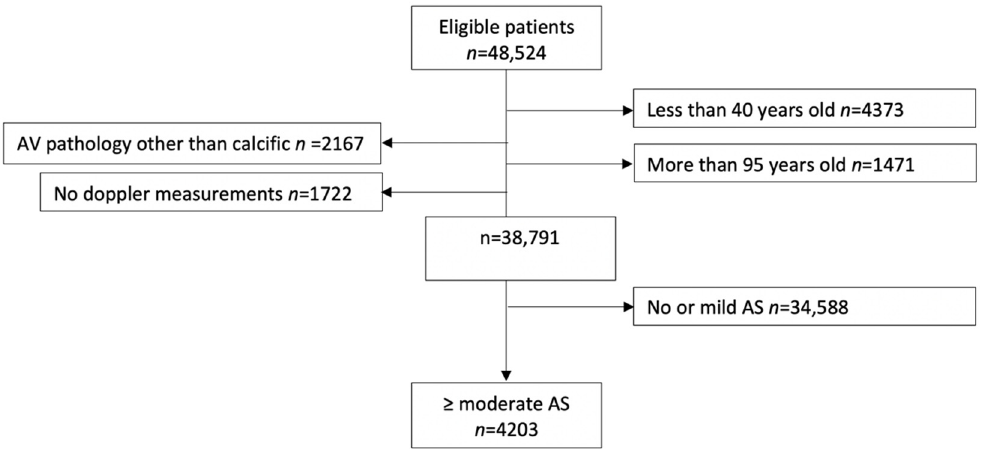
Figure 1. Cohort-building study flow diagram. Patients less than 40 and more than 95 years old, patients missing all echocardiographic parameters (AVA, DVI, V-max, PG-mean), and patients with valve pathology other than calcific (rheumatic, HOCM, tumor, endocarditis, and patients who had AVR as a part of aneurysm or dissection repair) were excluded.